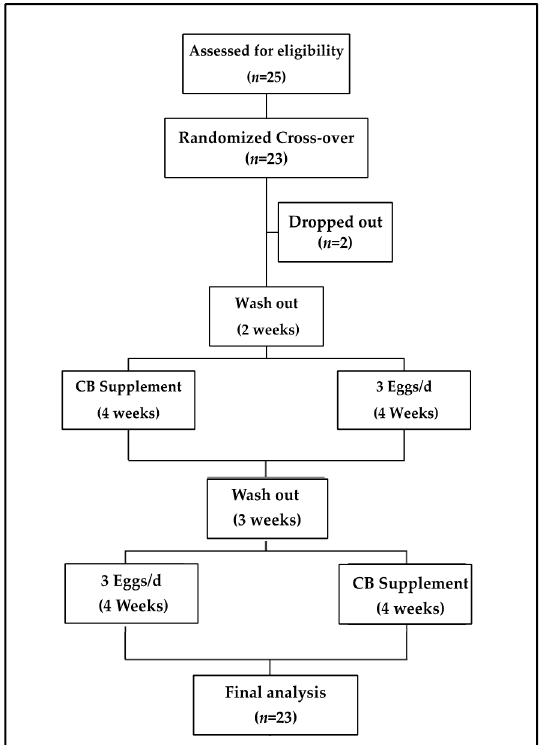
Figure 1. Experimental design. Subjects underwent a 2 week washout period before being randomly allocated to either 3 eggs/d or CB supplement (~400 mg) for 4 weeks. Following a 3 week washout period, they were assigned to the alternate treatment. Blood to measure choline, TMAO, and other metabolites and feces was collected at baseline and the end of each dietary period.